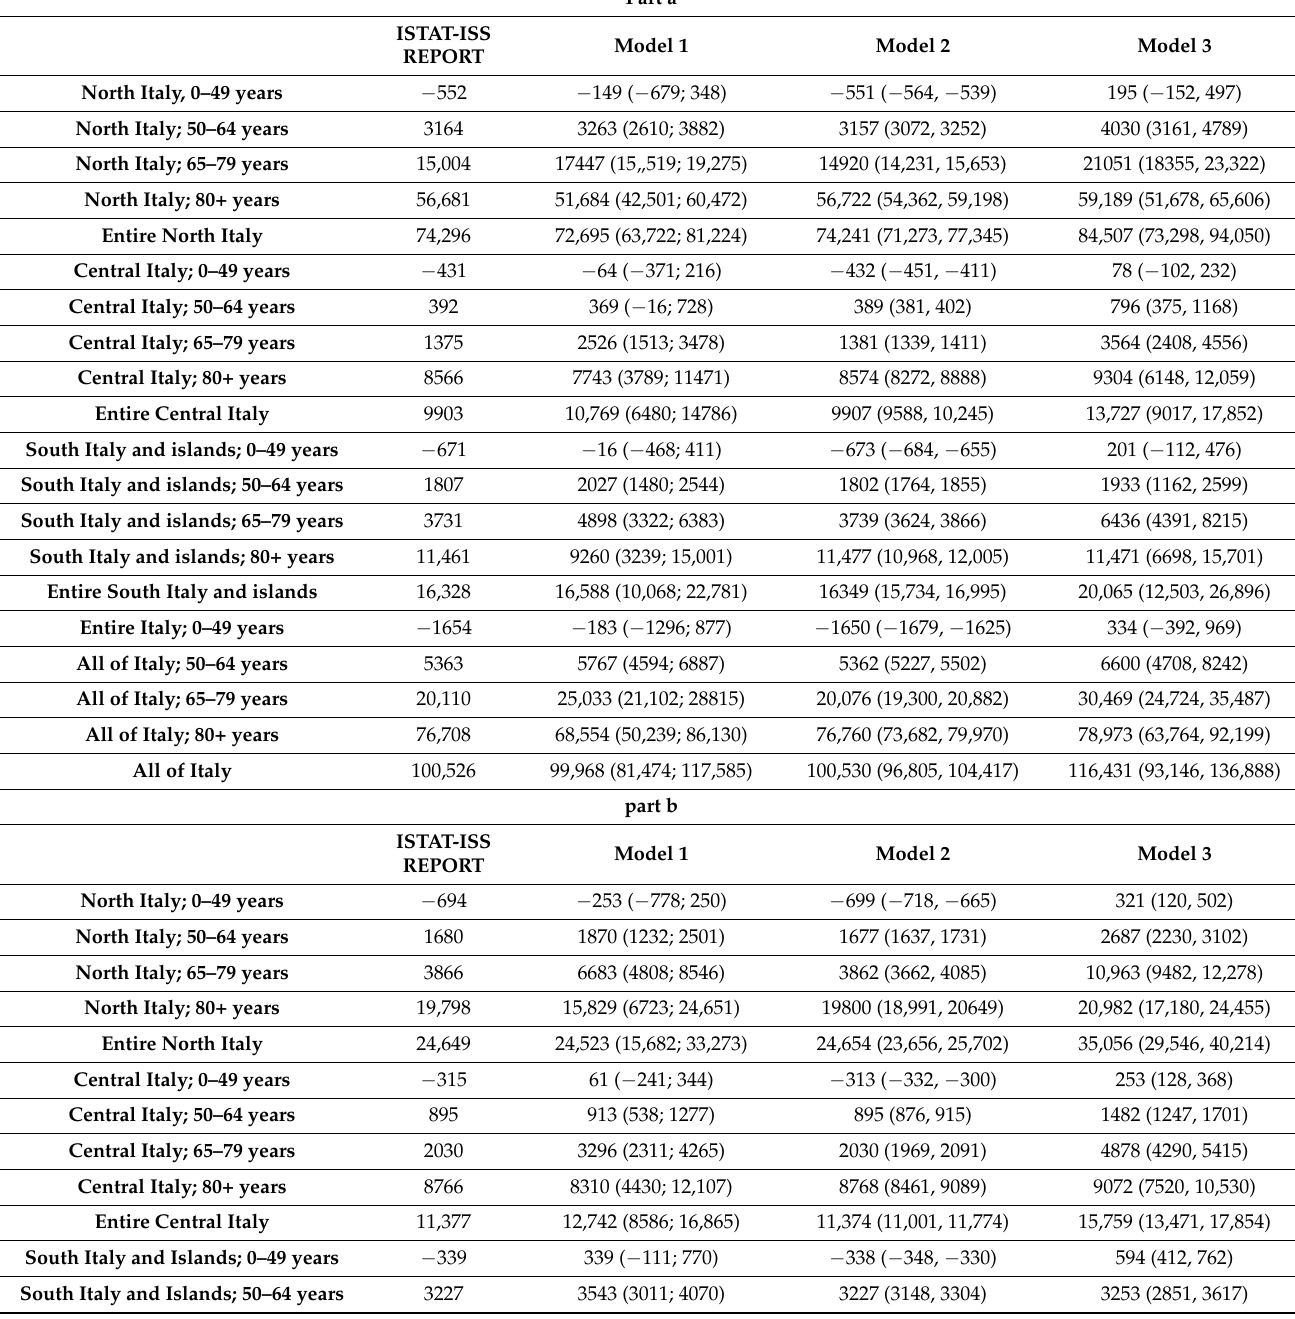
Table 2. part a. Excess mortality estimates for different models according to age and geographical macro-area for the year 2020. The 95% confidence intervals are included for the three models. part b. Excess mortality estimates for different models according to the age and geographical macro-area for the year 2021. The 95% confidence intervals are included for the three models. part c. Relative excess mortality estimates for different models according to age and geographical macro-area for the year 2020. part d. Relative excess mortality estimates for different models according to age and geographical macro-area for the year